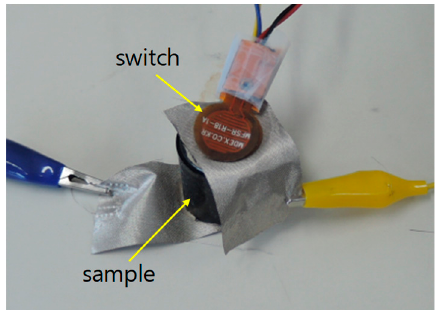
Figure 7. Stack of force indicating switch and cylindrical sample for response time test.